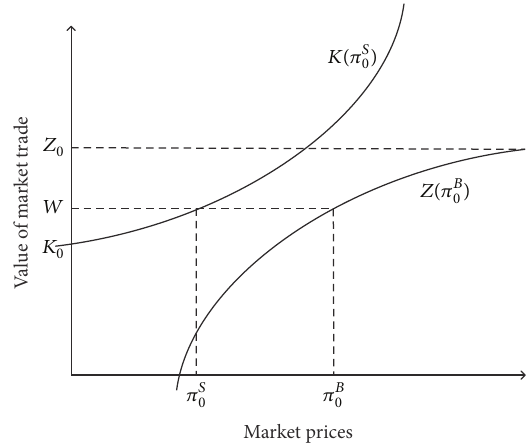
Figure 4: Market sell cost and market buy cost functions. Notice that above property is true for all values of (𝜋 𝑗0 ) and (𝜋 0𝑖 ) . Any change in values of (𝜋 𝑗0 ) results in parallel shift of the function 𝐾(𝜋 𝑆 0 ) by the value − ∑ 𝑗 𝜋 𝑗0 𝑞 𝑗 . Any change in values of (𝜋 0𝑖 ) results in parallel shift of function 𝑍(𝜋 𝐵 ) by ∑ 𝜋 𝑑 0𝑖 𝑗 . Due to market balance, any deviation in 𝑗 0 𝜋 𝑞 ∑ 𝑗0 𝑗 must be compensated by a change in 𝑗 𝜋 𝑞 + ∑ 𝜋 𝑑 ∑ 𝑗0 𝑗 0𝑖 𝑗 is constant. Finally, any shift in 𝑗 𝑗 must also result in the same shift in 𝑍(𝜋 𝐵 0 ) . For different prices (𝜋 ) and (𝜋 ) the gap between 𝐾(𝜋 𝑆 𝑗0 0𝑖 and PoF (𝑊) does not change when the values (𝜋 𝑗0 ) and (𝜋 0𝑖 ) are changing. Therefore, PoF (𝑊) is a convex function for any prices (𝜋 𝑗0 ) and (𝜋 0𝑖 )